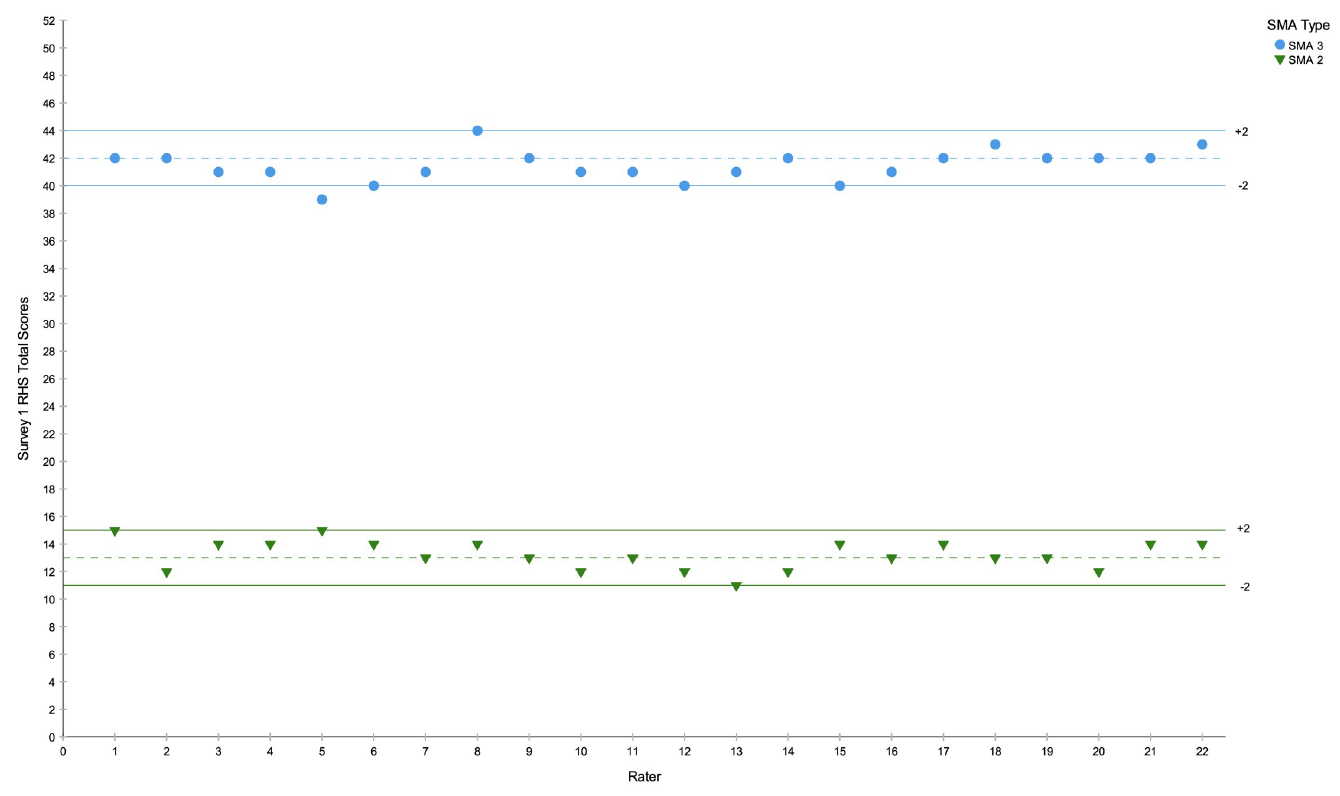
Fig 1. SMA type 2 and 3 RHS inter-rater total scores with mean and ± 2 expert opinion of acceptable margin of